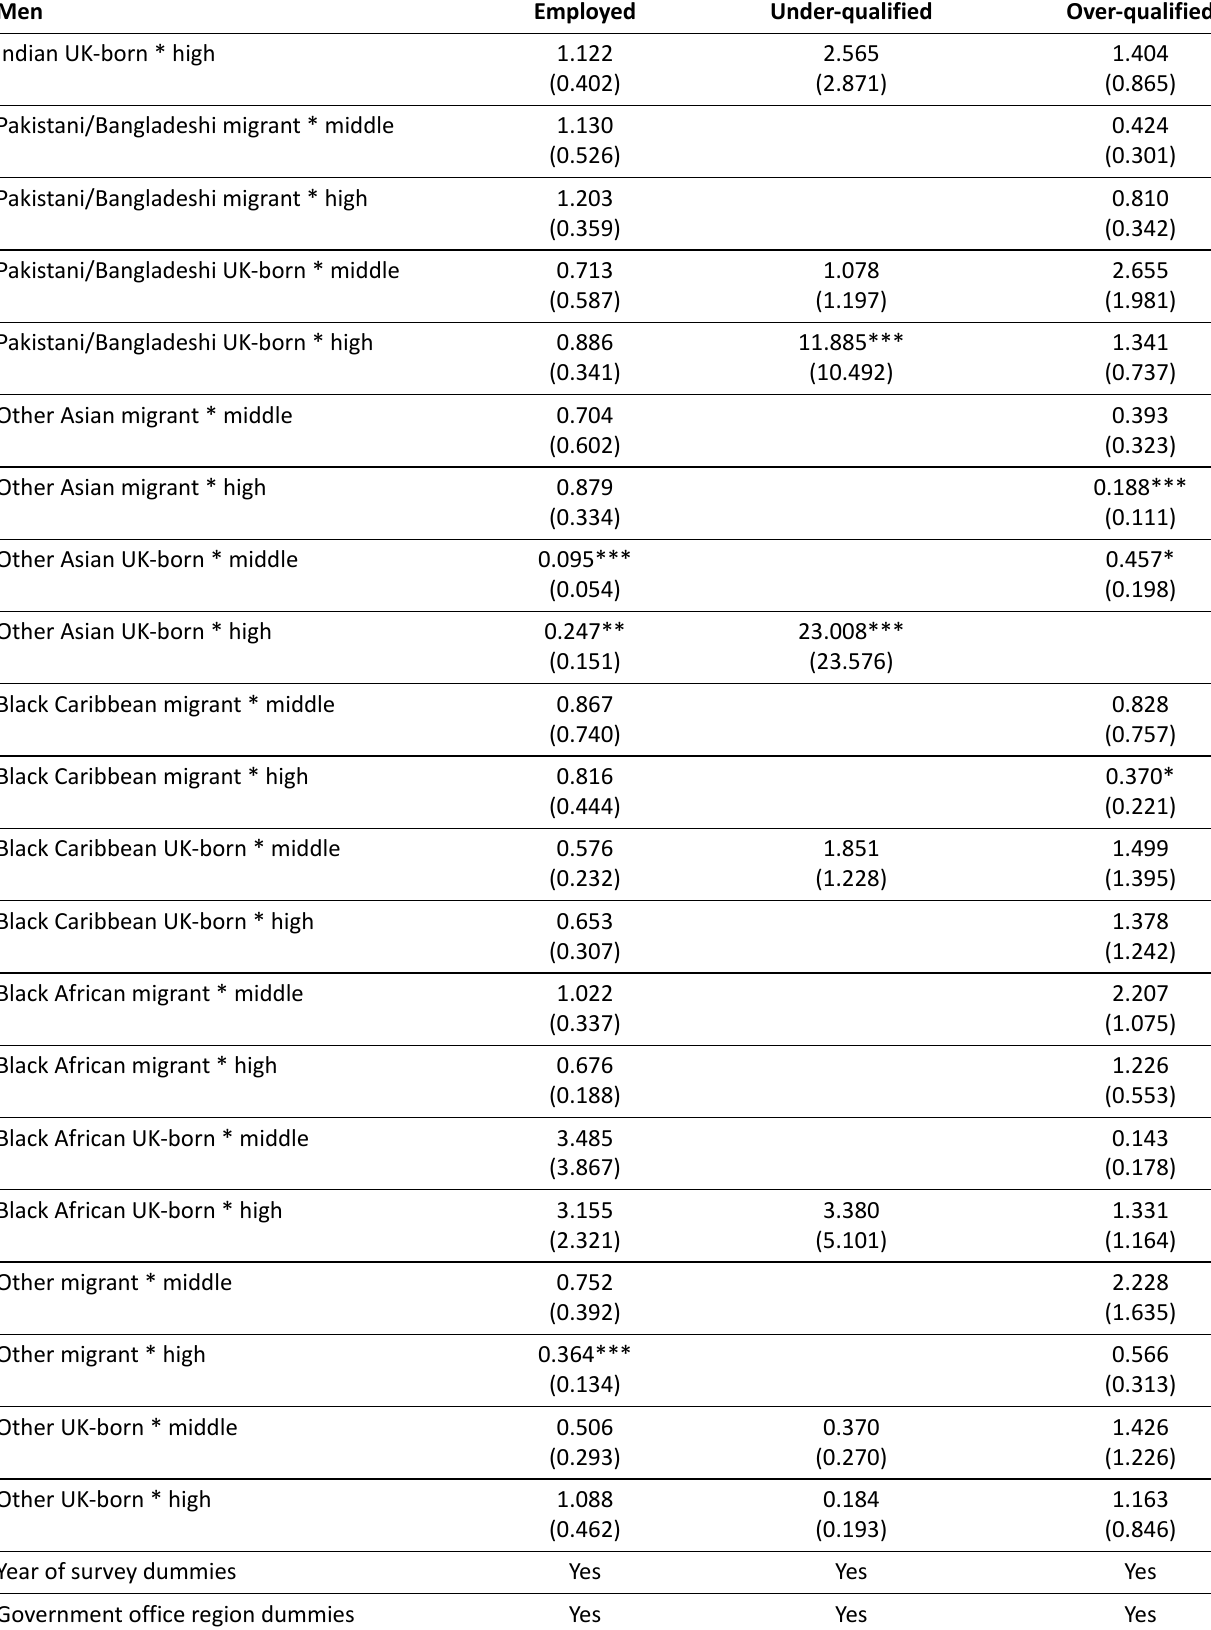
Table A3. (Cont.) Binary logistic regression model (odds ratio) of employment, under- and over-qualification for men.